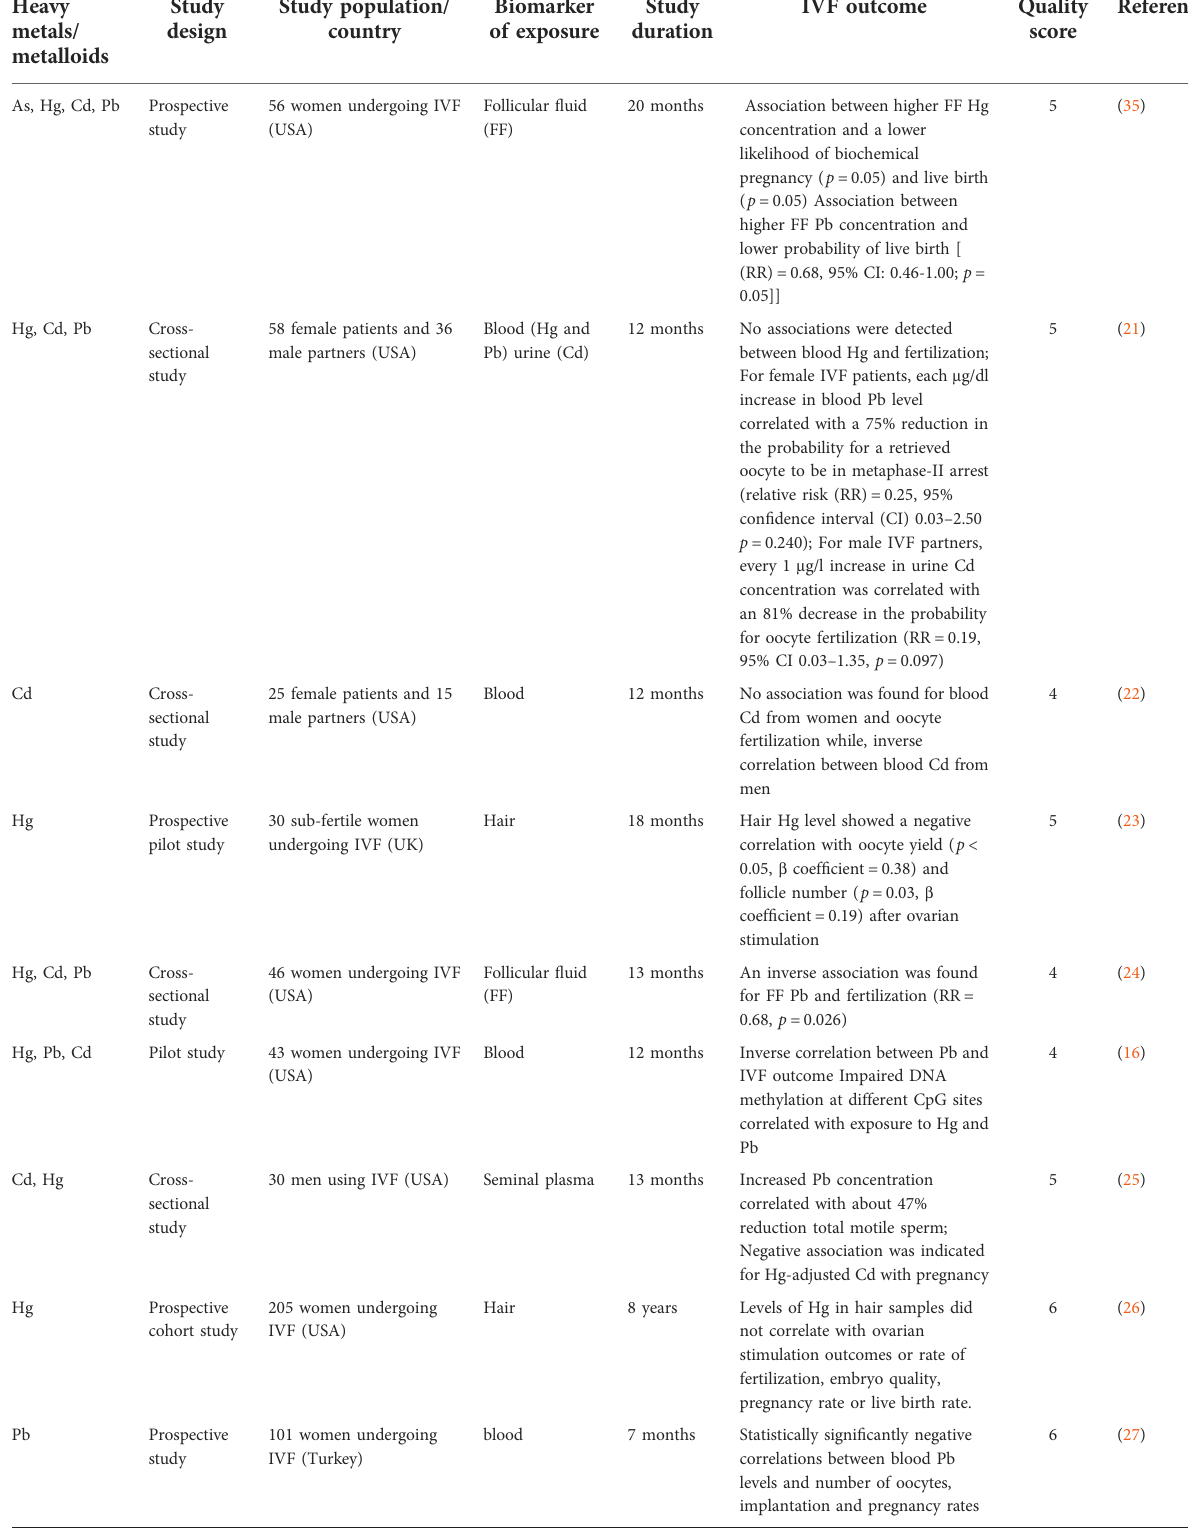
TABLE 1 Clinical studies on heavy metals/metalloids and IVF